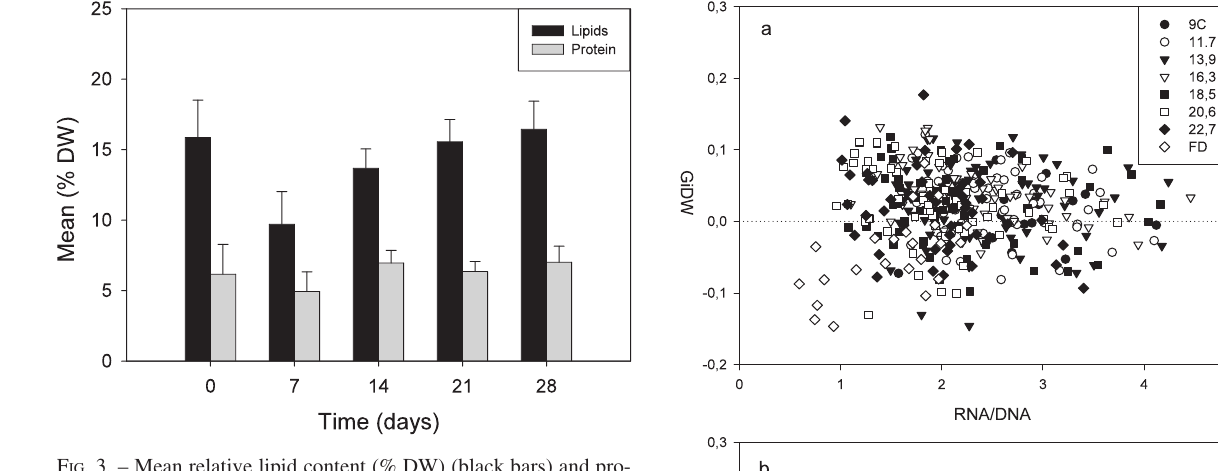
F IG . 3. – Mean relative lipid content (% DW) (black bars) and pro- tein content (% DW) (grey bars) along with standard deviation over sampling interval.